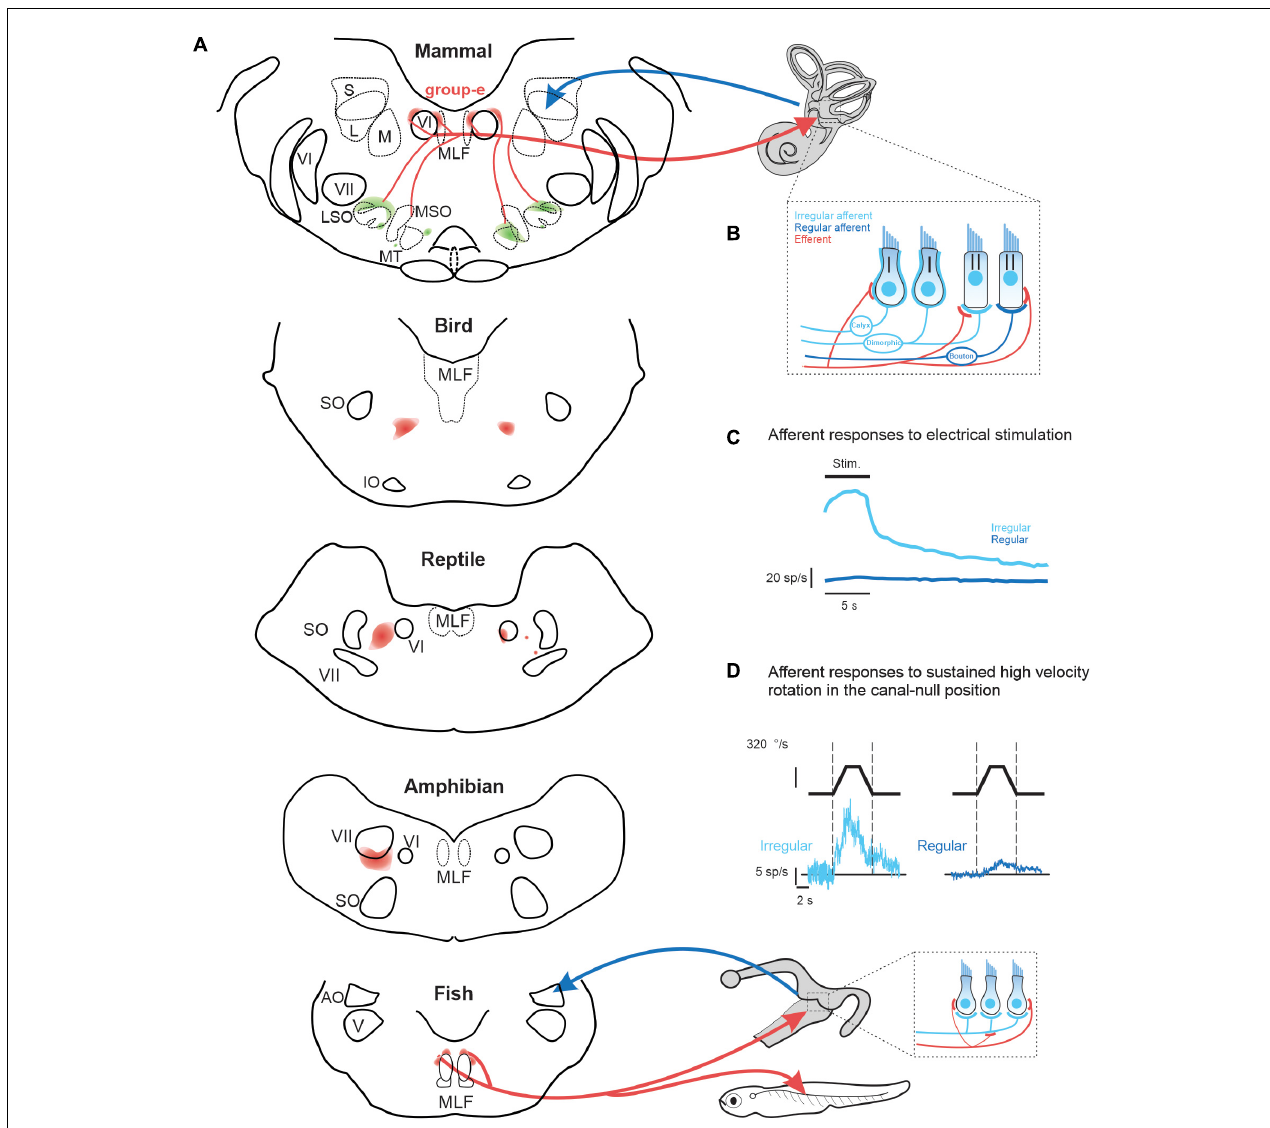
FIGURE 1 | (A) of vestibular efferent (red) and afferent (blue) projections across vertebrates including: mammals (squirrel monkey: Goldberg and Fernandez, 1980), birds (pigeon: Eden and Correia, 1981), reptile (lizard: Barbas-Henry and Lohman, 1988), amphibians (toad: Pellegrini et al., 1985), and fish (toadfish: Highstein and Baker, 1986). (B) In mammals, irregular afferents (light blue) typically innervate both type I and II hair cells (i.e., dimorphic afferents), while regular afferent (dark blue) more selectively innervate type II hair cells. Note that the mammalian vestibular efferent system innervates type II hair cells and their afferent bouton endings, as well as the afferent calyces of type I hair cells (Lysakowski and Goldberg, 1997, 2008). In contrast, in lower vertebrates, which do not have hair cells with calyx endings, the vestibular efferent system innervates type II hair cells and, in some species, such as the toadfish (Sans and Highstein, 1984) also their afferent bouton endings [ bottom inset , (A) ]. (C) Comparison of the population-averaged efferent-mediated responses of irregular vs. regular afferents to electrical microstimulation of central “group-e” neurons (Goldberg and Fernandez, 1980). (D) Efferent-mediated population responses of irregular ( left ) vs. regular ( right ) afferents to sustained high amplitude rotation in the canal-null position (Sadeghi et al., 2009). Note, in contrast to their conventional evoked by natural head motion, afferents displayed excitatory responses for stimulation in both directions—termed a type III response. AO, nucleus anterior octavus; LSO, MSO, MT, lateral and medial superior